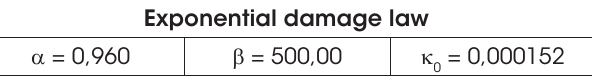
Parameters adopted for the simulation of the L-Shaped panel